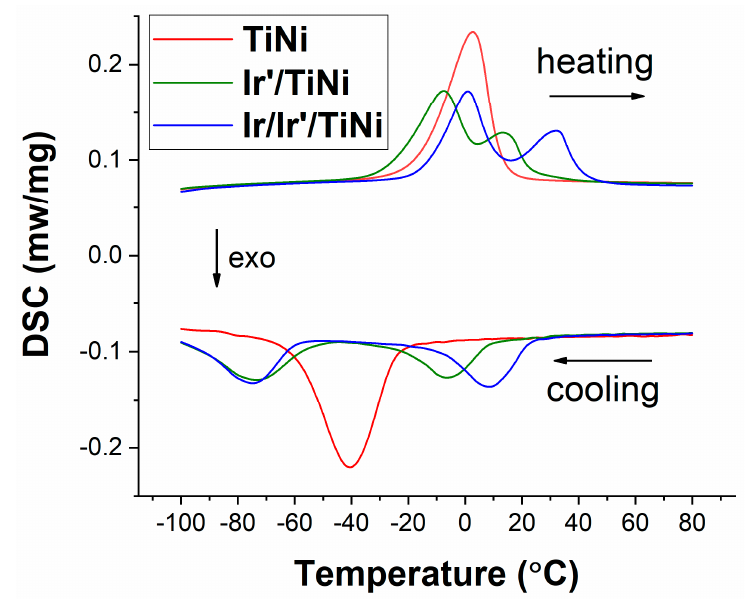
Figure 12. DSC curves for the TiNi substrates and those all-side-coated with iridium Table 2. Deposition conditions, growth rate and coating thickness of the samples of compact irid- ium layers on Si (100).